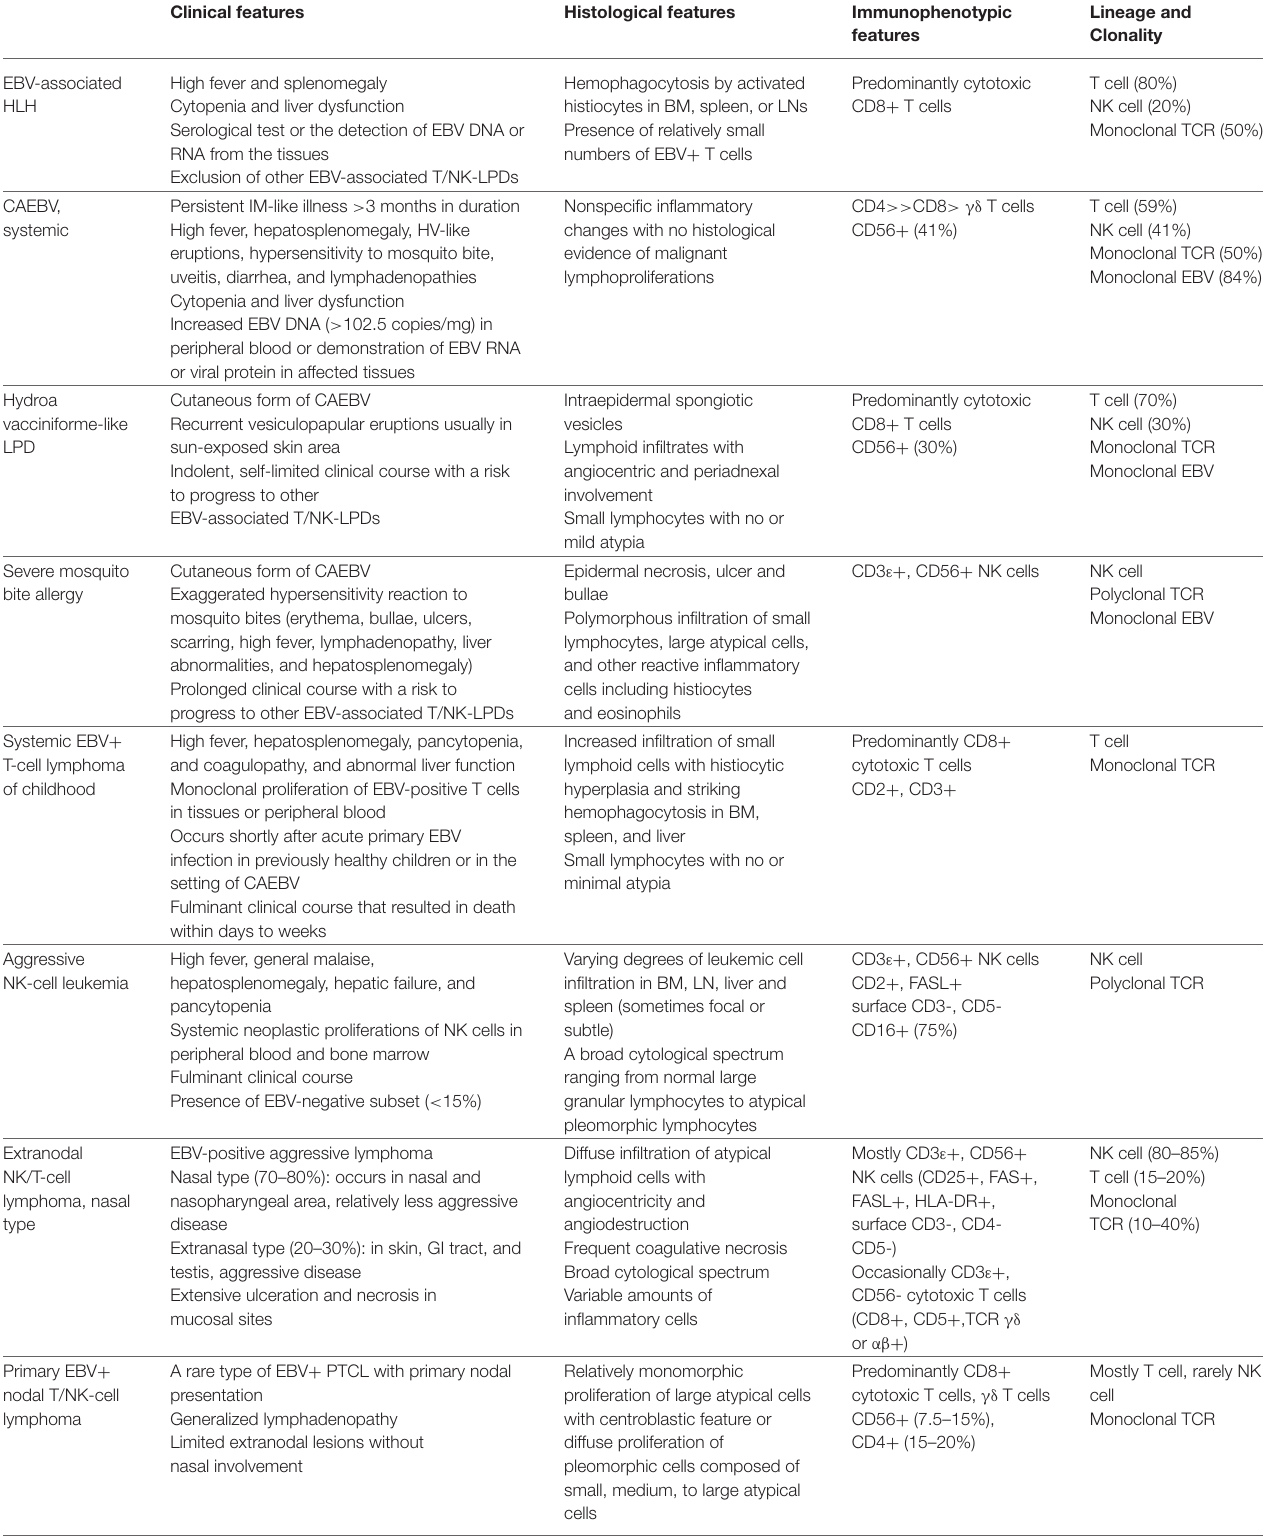
TABLE 2 | Summary of pathological features of EBV-associated T and NK- cell lymphoproliferative